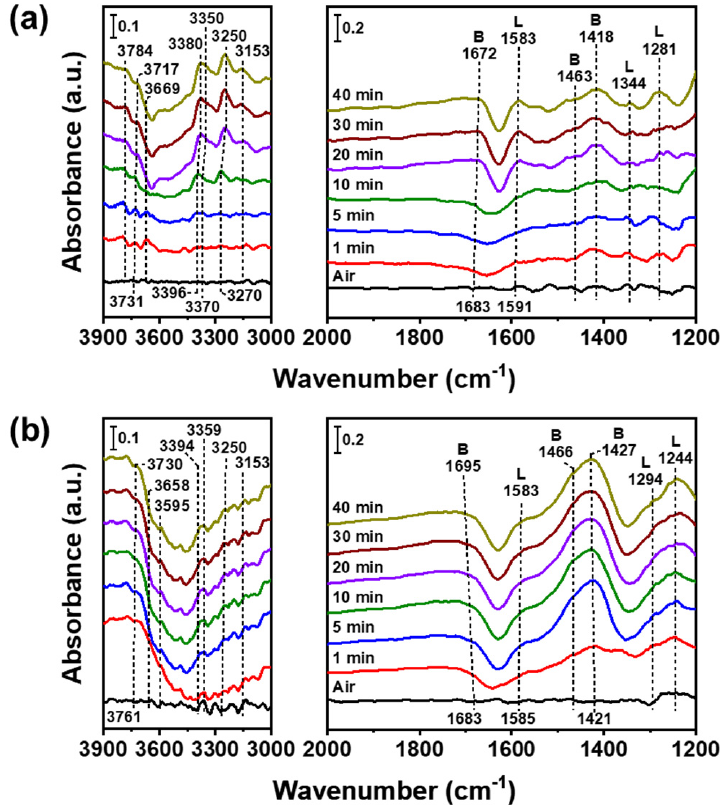
Figure 5. In situ Fourier − transform infrared spectra of ammonia adsorption depending on the reaction time over ( a ) V 2 O 5 (IM)–WO 3 (IM) and ( b ) V 2 O 5 (P)–WO 3 (P) at 200 °C. Conditions: [NH 3 ] = 500 ppm (when used) and N 2 as the balance.